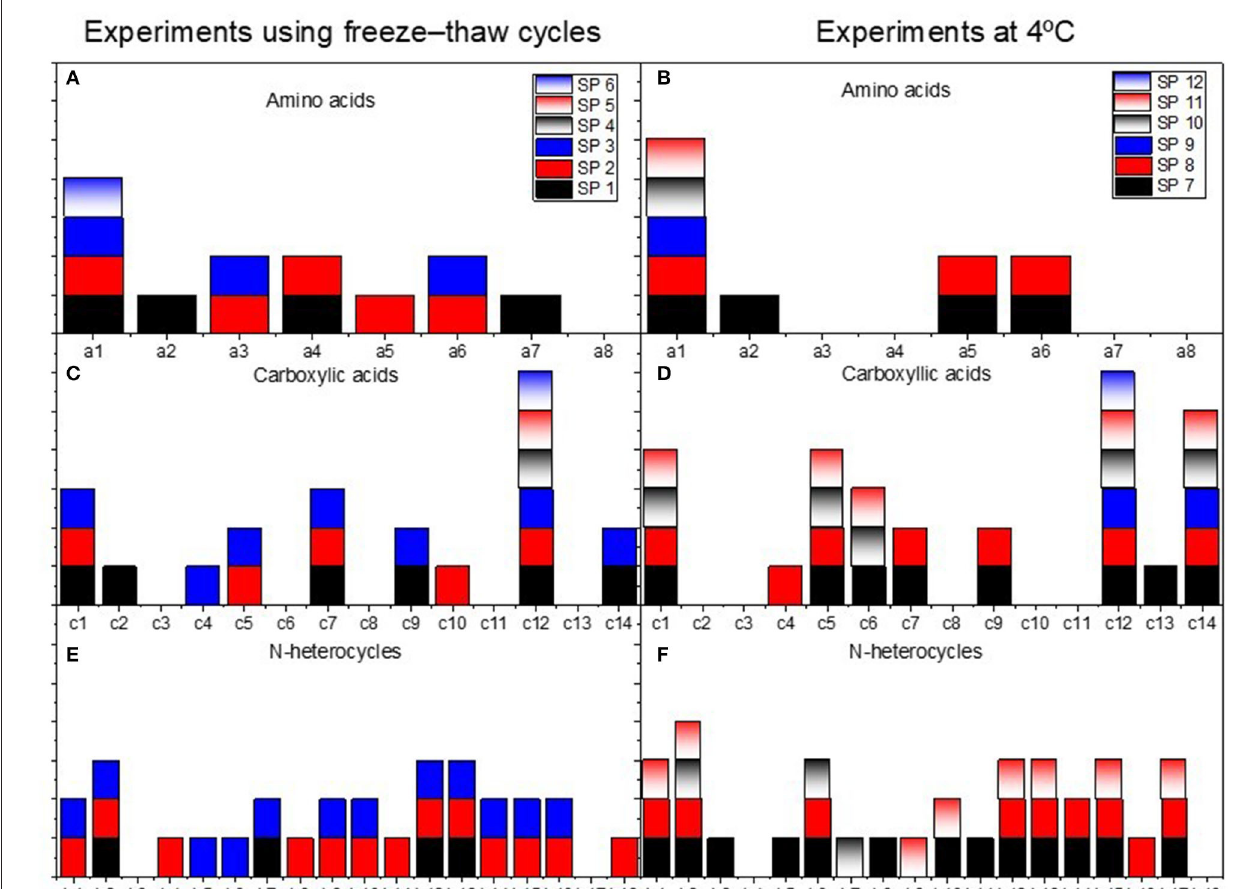
FIGURE 4 | Organic polar compounds identified as their TMS-derivatives via GC-MS in acid-hydrolyzed soluble NH 4 CN polymers synthesized under the conditions indicated in Table 1 . (A–C) Correspond to the amino acids, carboxylic acids, and N-heterocycles, respectively, found in soluble NH 4 CN polymers synthetized in the presence of freeze-thaw cycles; (D–F) correspond to amino acids, carboxylic acids, and N-heterocycles, respectively, found in soluble NH 4 CN polymers synthetized at 4 ◦ C. The numbers on the abscissa correspond to the enumeration of analytes shown in Figure 1 . The colored bars indicate the presence of a concrete analyte in the corresponding